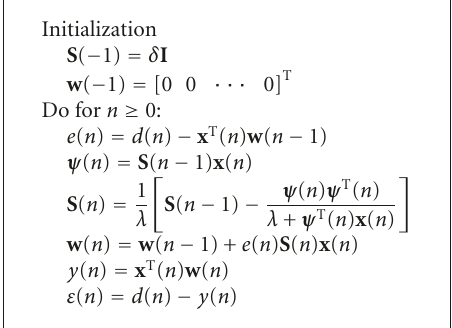
Algorithm 1: Complete RLS algorithm.